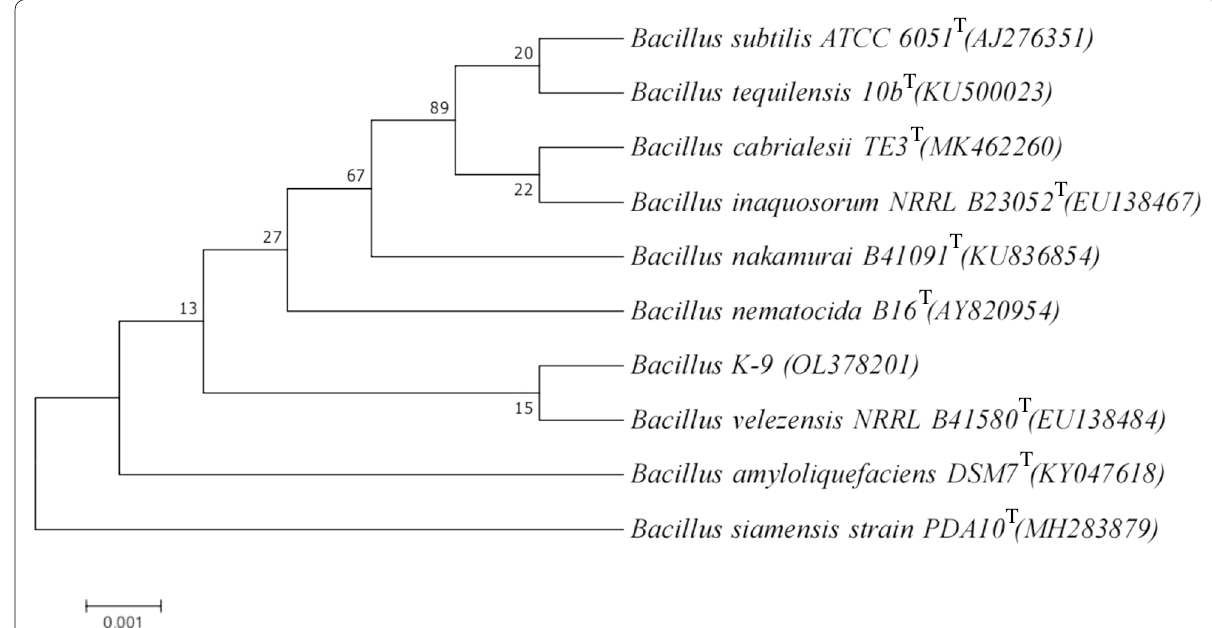
Fig. 2 Phylogenetic tree of strain K-9 constructed based on type strain 16S rRNA gene sequence. Bootstrap values (%) presented at the branches were calculated from 1000 replications. The scale bar means 0.1% sequence